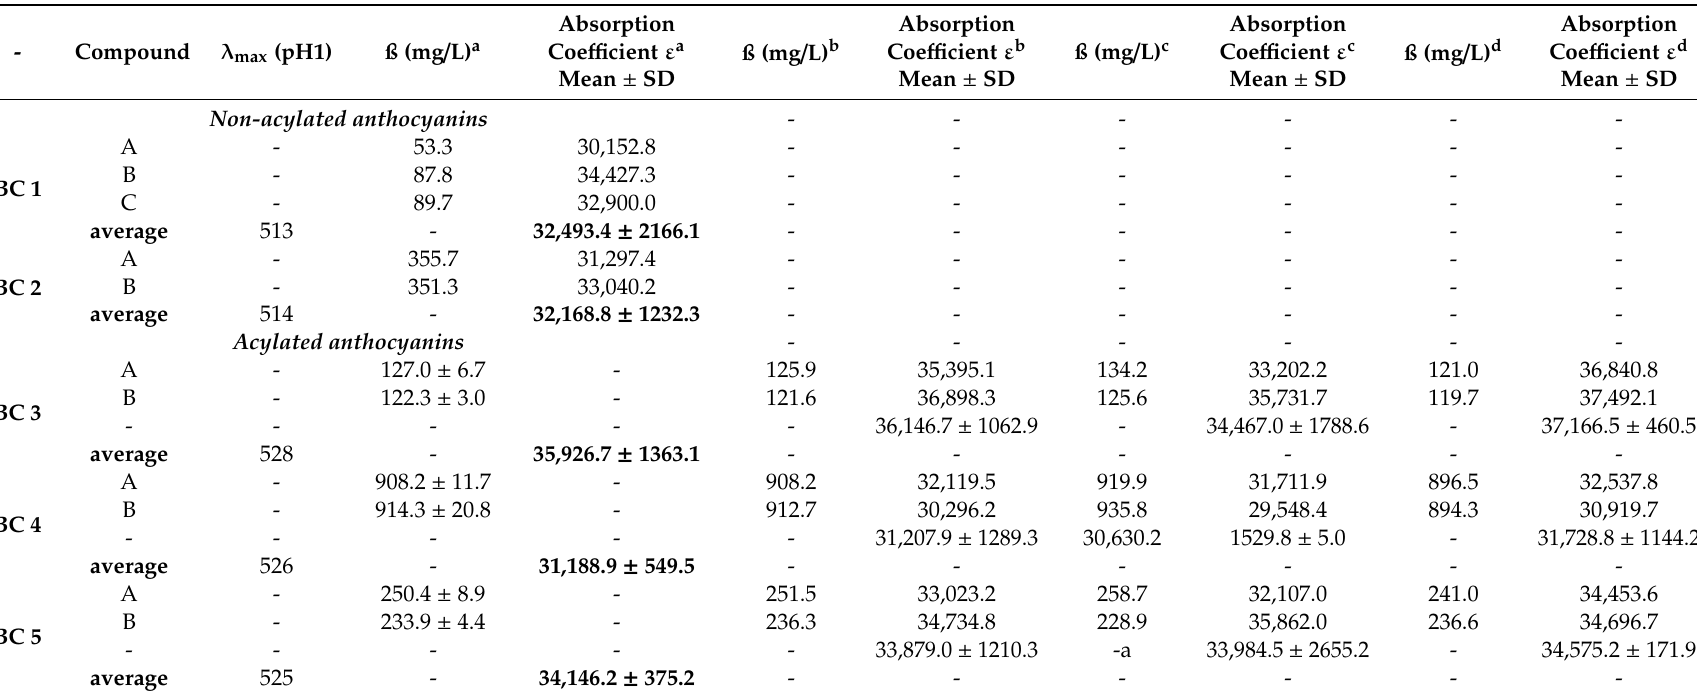
Table A3. Assigned absorption coe ffi cient ε at λ max of black carrot anthocyanins based on the concentration ß determined by